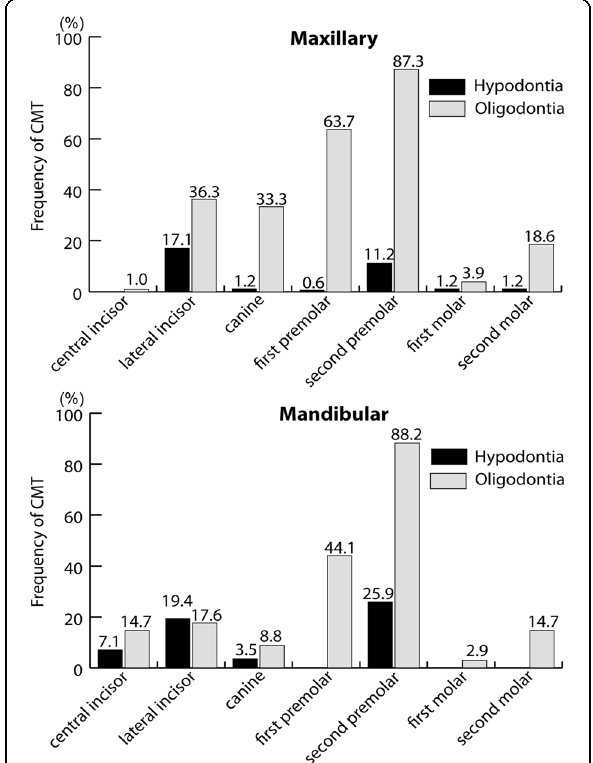
Fig. 1 Frequency of congenitally missing tooth type in Japanese tooth agenesis